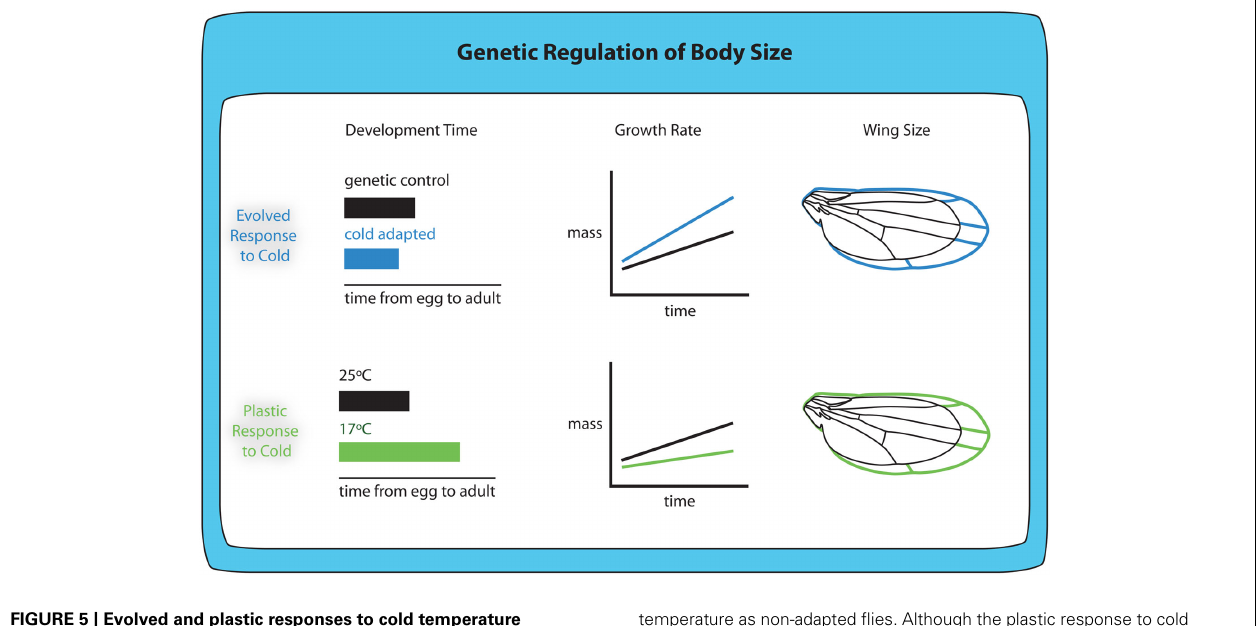
FIGURE 5 | Evolved and plastic responses to cold temperature produce larger animals with different size-related phenotypes. Cold-adapted flies show shorter development times, increased growth rate and larger body and wing size when reared at the same